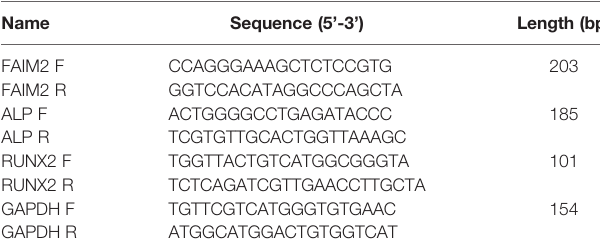
TABLE 1 | The information of the primers for real-time